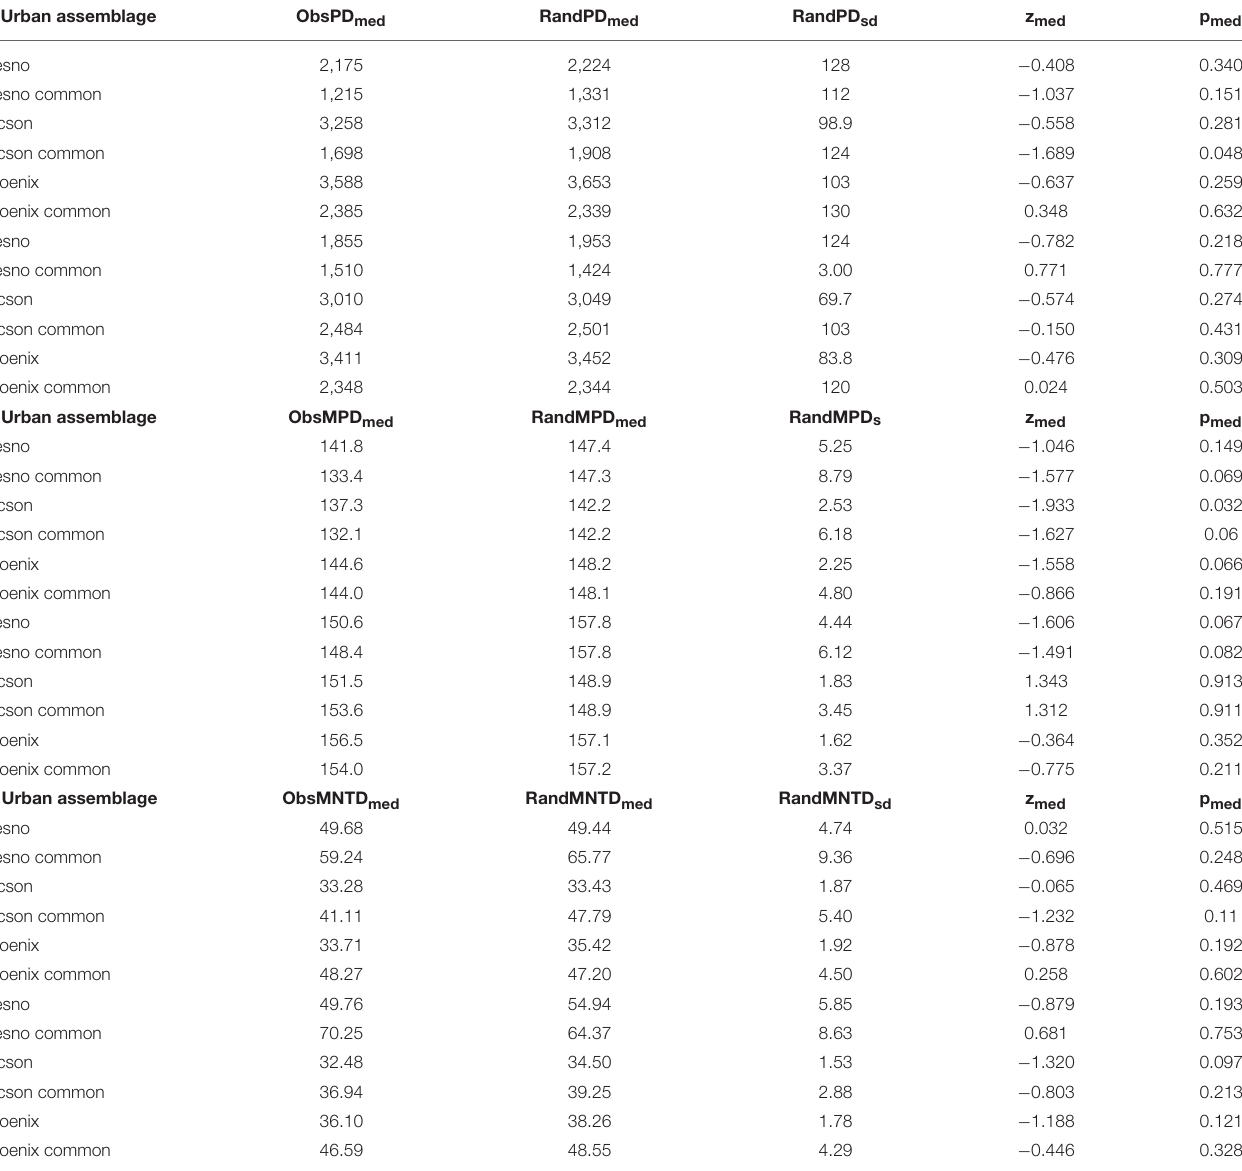
TABLE 2 | Results of PD (a), MPD (b), and MNTD (c) bootstrapping